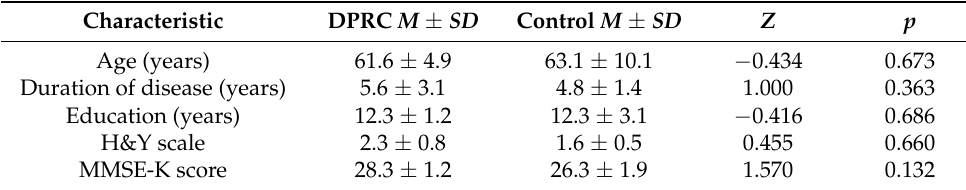
Table 3. Participants’ demographic information.